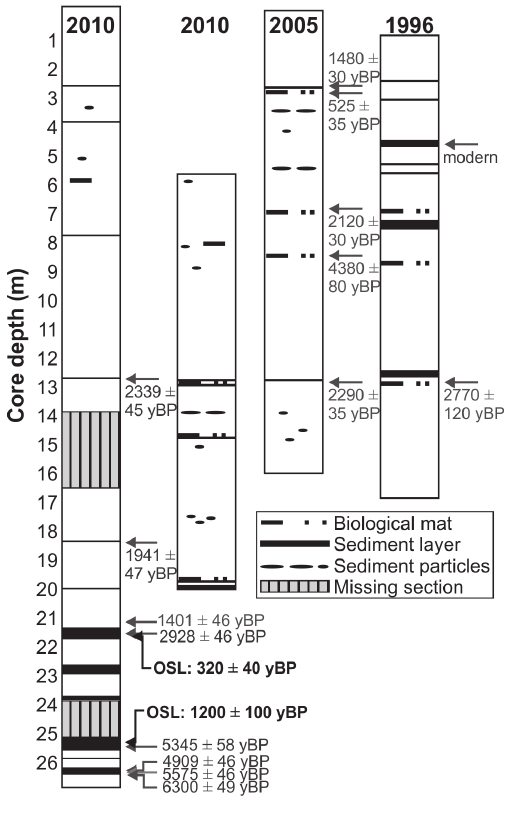
Figure 4. Lake Vida ice core logs from 1996, 2005 and 2010. Two ice cores were drilled in 2010. Where samples were missing in the 27m core (between 16 and 20m), the 20m ice core was subsam- pled. For core locations in 1996 and 2005, see Doran et al. (2003) and Murray et al. (2012). Surface heights are adjusted to the 2010 lake elevation.